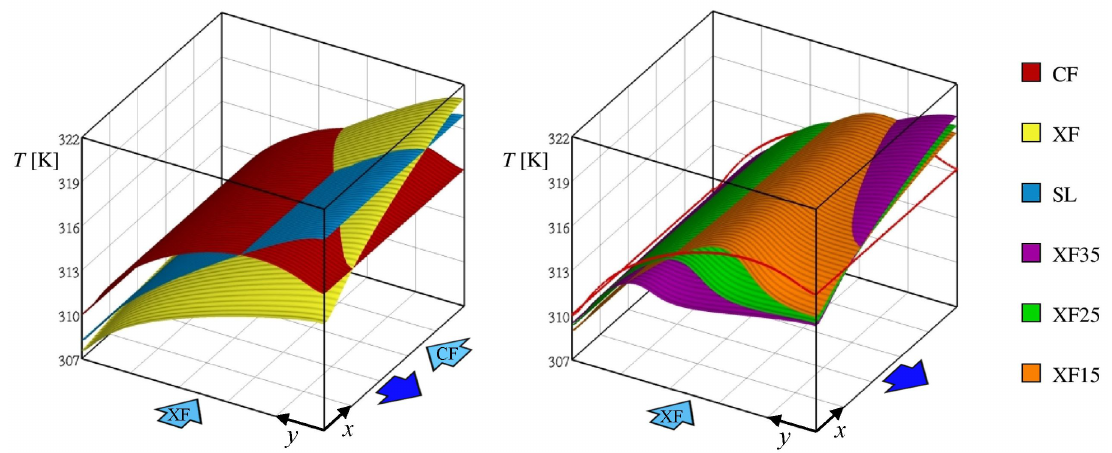
Figure 3. Bottom wall temperature distributions for six MCHS configurations and ˙ V = 2.5 mL/s (dark blue arrow: bottom layer; light blue arrow: top layer).